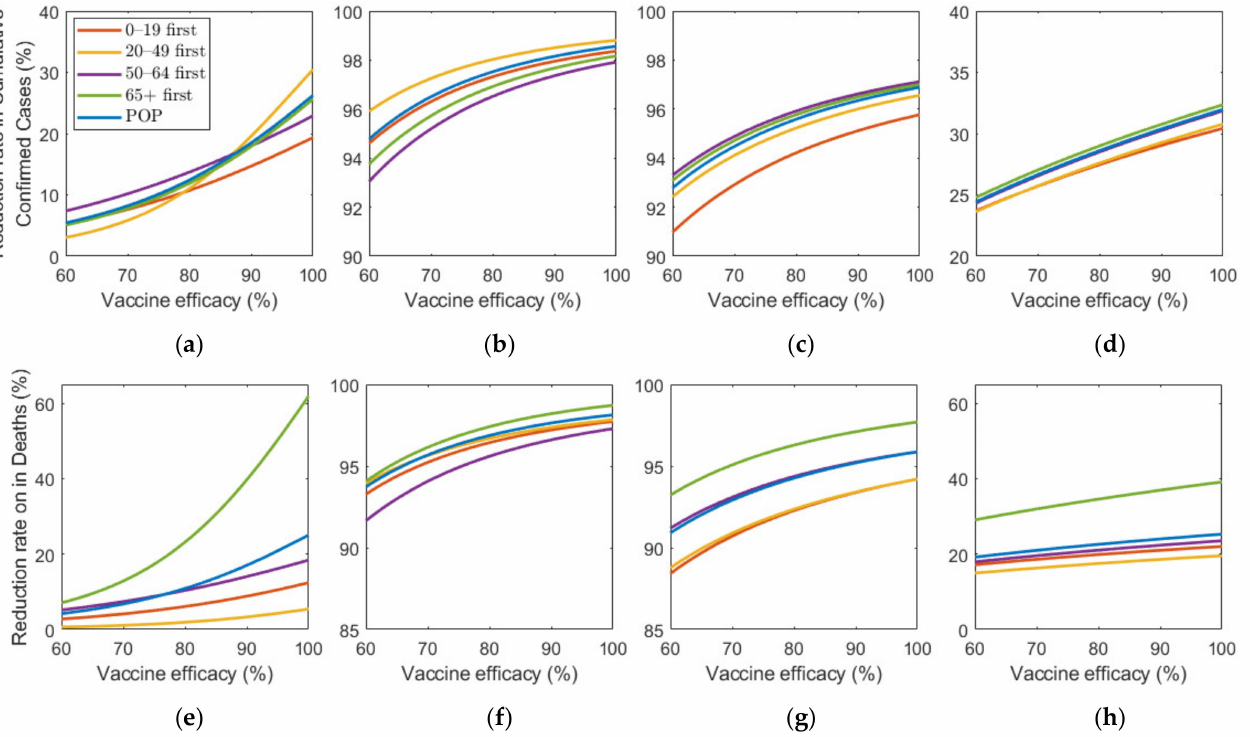
Figure 9. Impact of vaccination efficacy on the reduction in cumulative confirmed cases and deaths for different SD levels: ( a , e ) 0, ( b , f ) 1, ( c , g ) 2, and ( d , h )